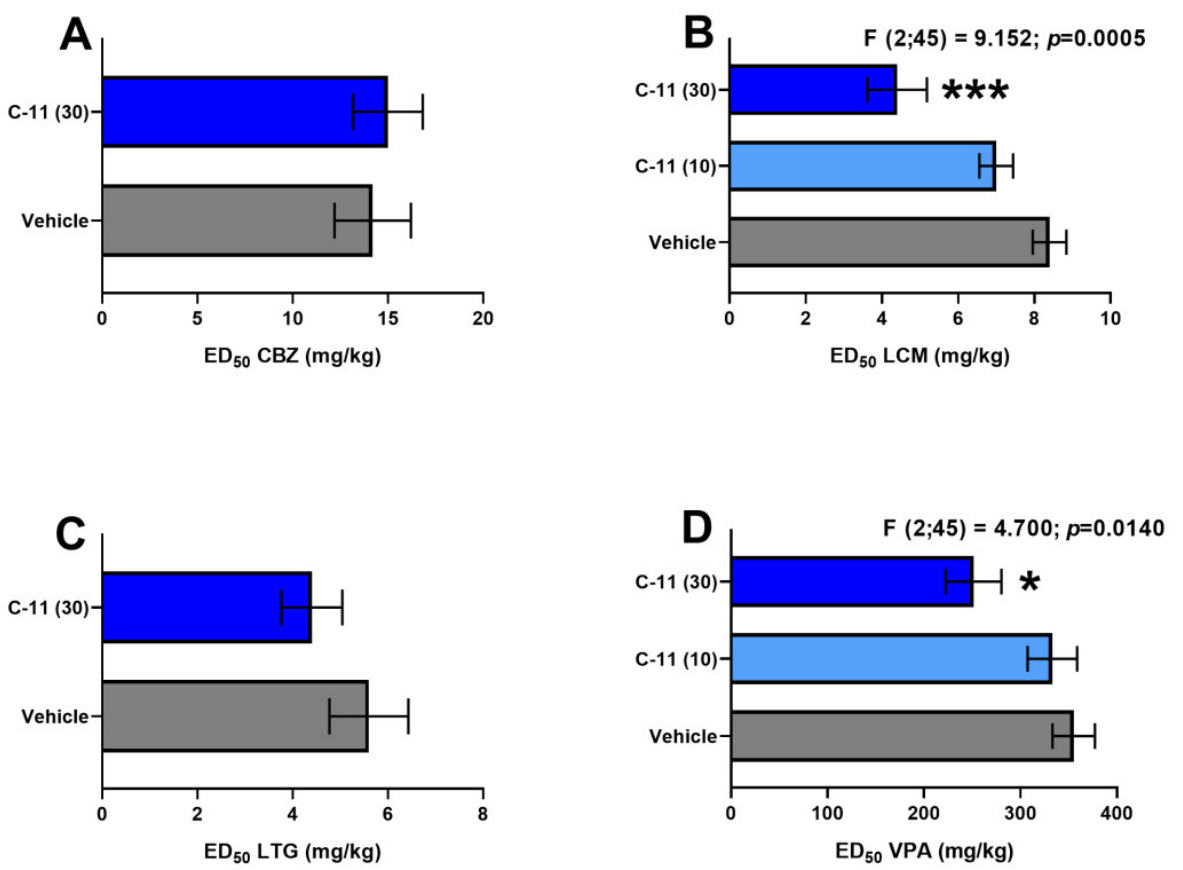
Figure 2. Effects of C-11 on the anticonvulsant potency of CBZ, LCM, LTG, and VPA in the MES model in mice. Columns represent median effective doses (ED 50 in mg/kg ± SEM) of antiepileptic drugs (CBZ ( A ), LCM ( B ), LTG ( C ) and VPA ( D )that protected half of the tested mice from tonic–clonic seizures. The log-probit method was used for calculating the ED 50 values. *** p < 0.001, * p < 0.05 vs. control (LCM, VPA + vehicle-treated) animals (one-way ANOVA and post-hoc Tukey–Kramer test).